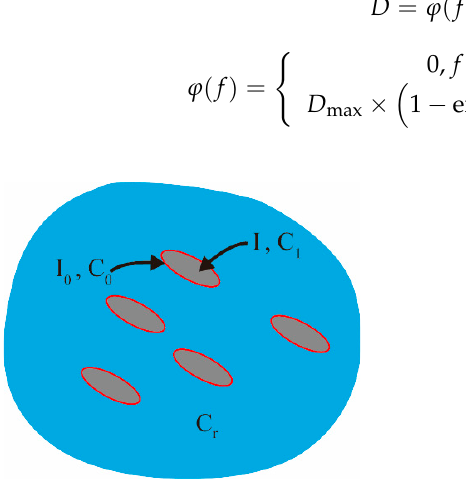
Figure 8. Double-inclusion model.